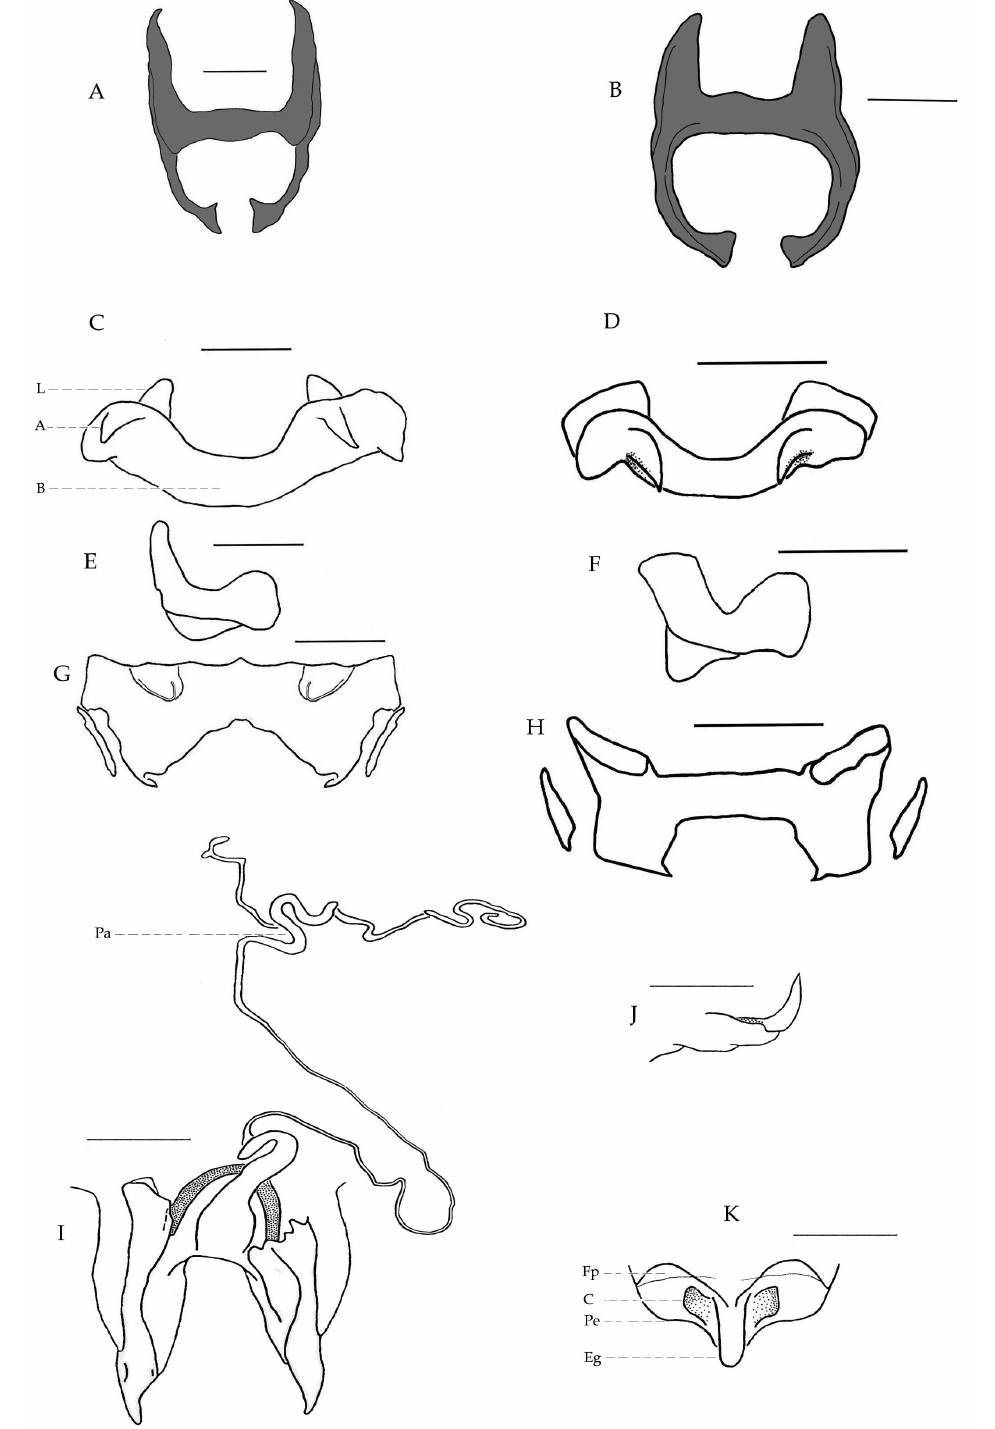
Fig. 8. Ectophallus, epiphallus, spermatheca and subgenital plate of Gemeneta spp. A, B. Ectophallus in ventral view; C, D. Epiphallus in axial view; E, F: Epiphallus in lateral view; G, H. Epiphallus in dorsal view; I. Spermatheca in dorsal view; J. Subgenital plate in lat- eral view; K. Subgenital plate in dorsal view; A, C, E, G, I, J, K. G. terrea and B, D, F, H. G. opilionoides ; Ancorae (A): a pair of processes or projections from the anterior margin or the dorsal surface of the epiphallus; Bridge (B): transverse part of epiphallus connecting the lateral parts; Lophi (L): lobiform processes near the posterior margin of the epiphallus; Columella (C): columnar structures on either side of the egg-guide in the subgenital plate; Egg-guide (Eg): median, dorsally produced part of the posterior edge in the subgenital plate; Floor pouches (Fp): pair of short anterior invaginations in the floor of the subgenital plate; Preapical appendix (Pa): preapical dilatation of the spermathecal duct; Posterior edge (Pe): pair of short posterior invaginations of the border that meets the floor in the subgenital plate. Scale bars = 0.5